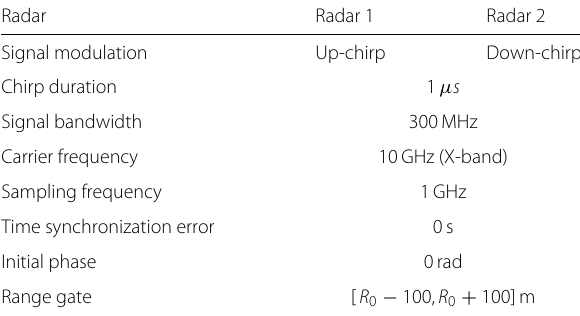
. a Time CPs. b Phase MF